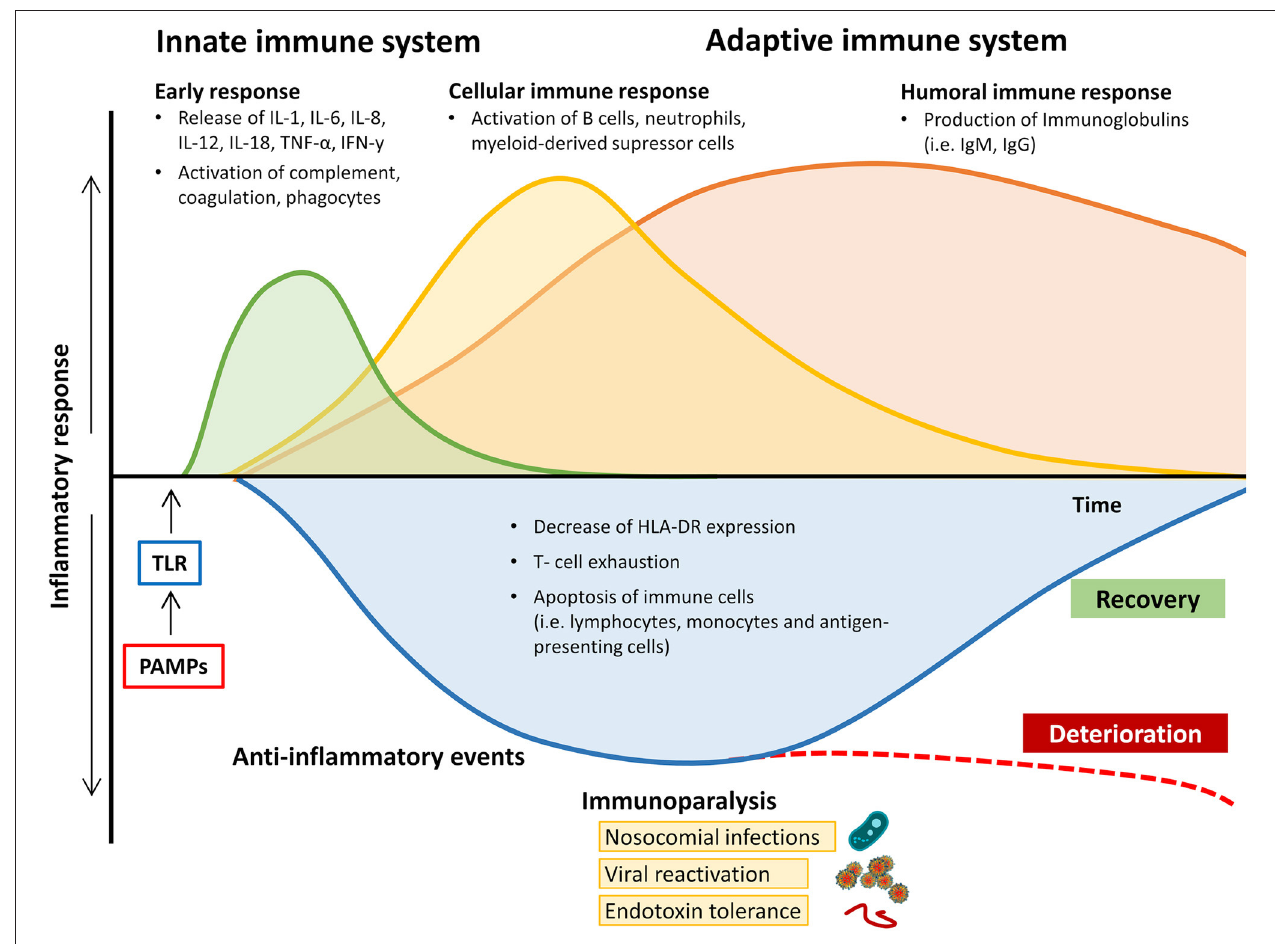
FIGURE 1 | Changes in pro- and anti-inflammatory response of the immune system during the course of sepsis and septic shock. HLA-DR, human leukocyte antigen-D related; IgM/G, immunoglobulin M/G; IL, interleukin; IFN-y, Interferon y; PAMPs, pathogen-associated molecular patterns; TNF- α , tumor necrosis factor alpha; TLR, toll-like